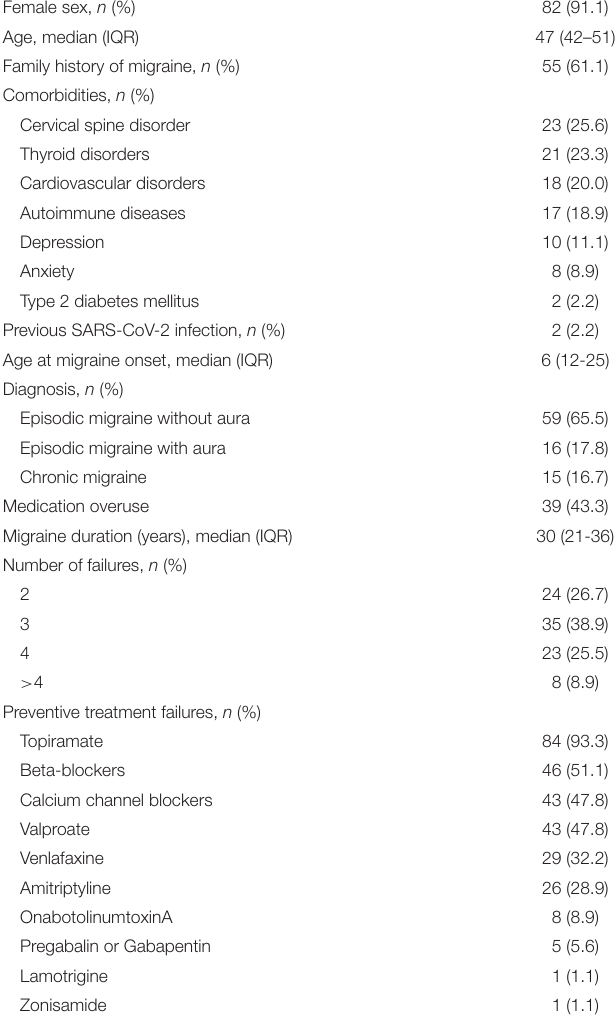
TABLE 1 | Characteristics of the study population ( n =